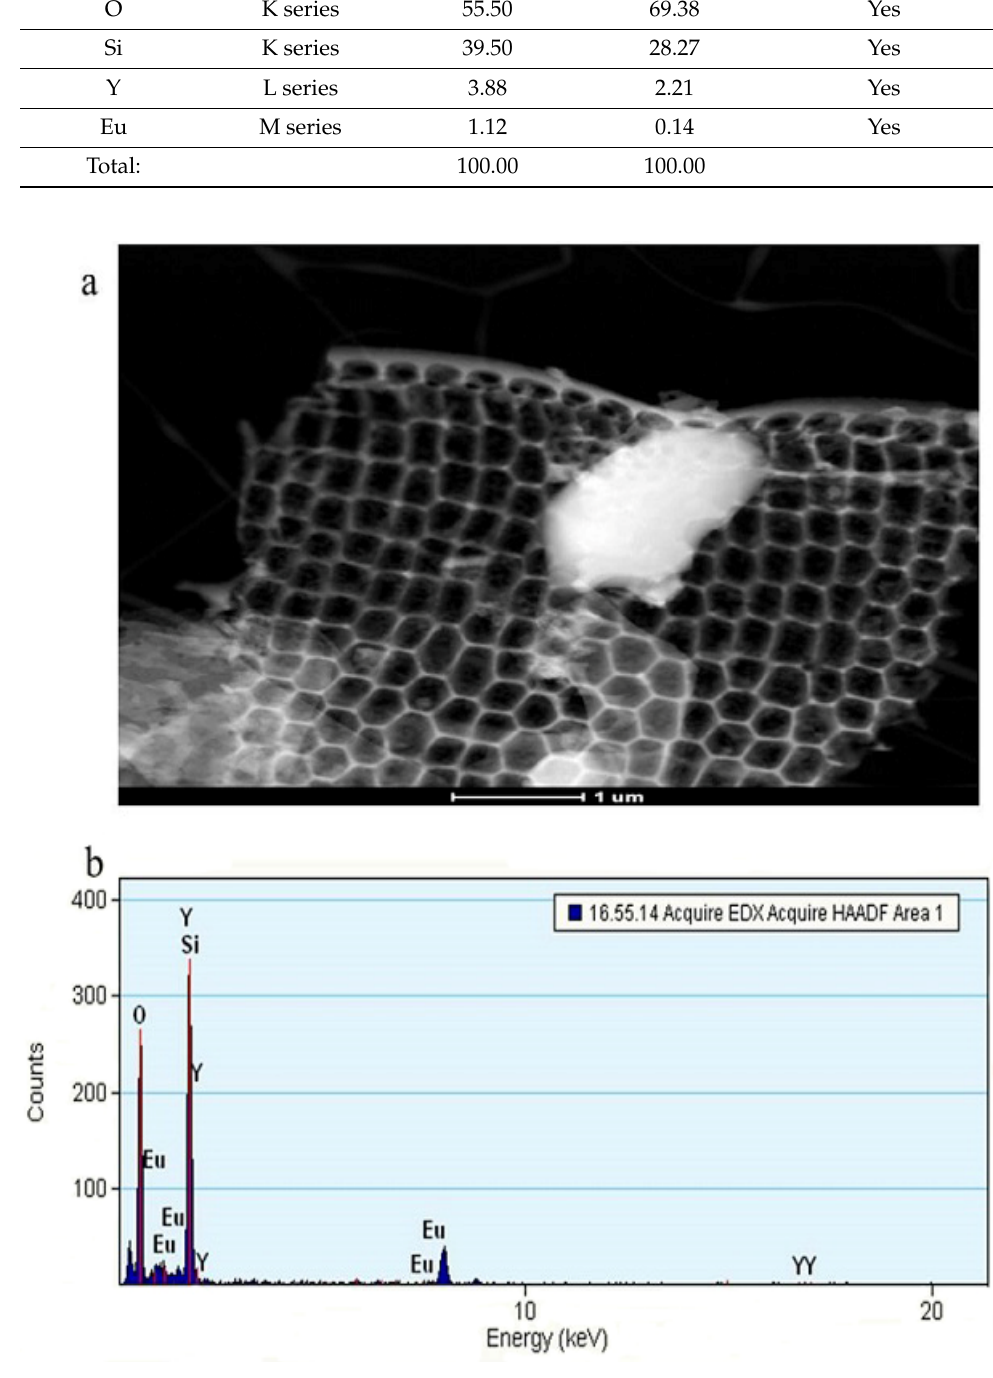
Figure 5. EDX spectra of diatom coated with 6% Eu-doped Y 2 O 3 nanoparticles. ( a ) elemental mapping; ( b ) XRD.